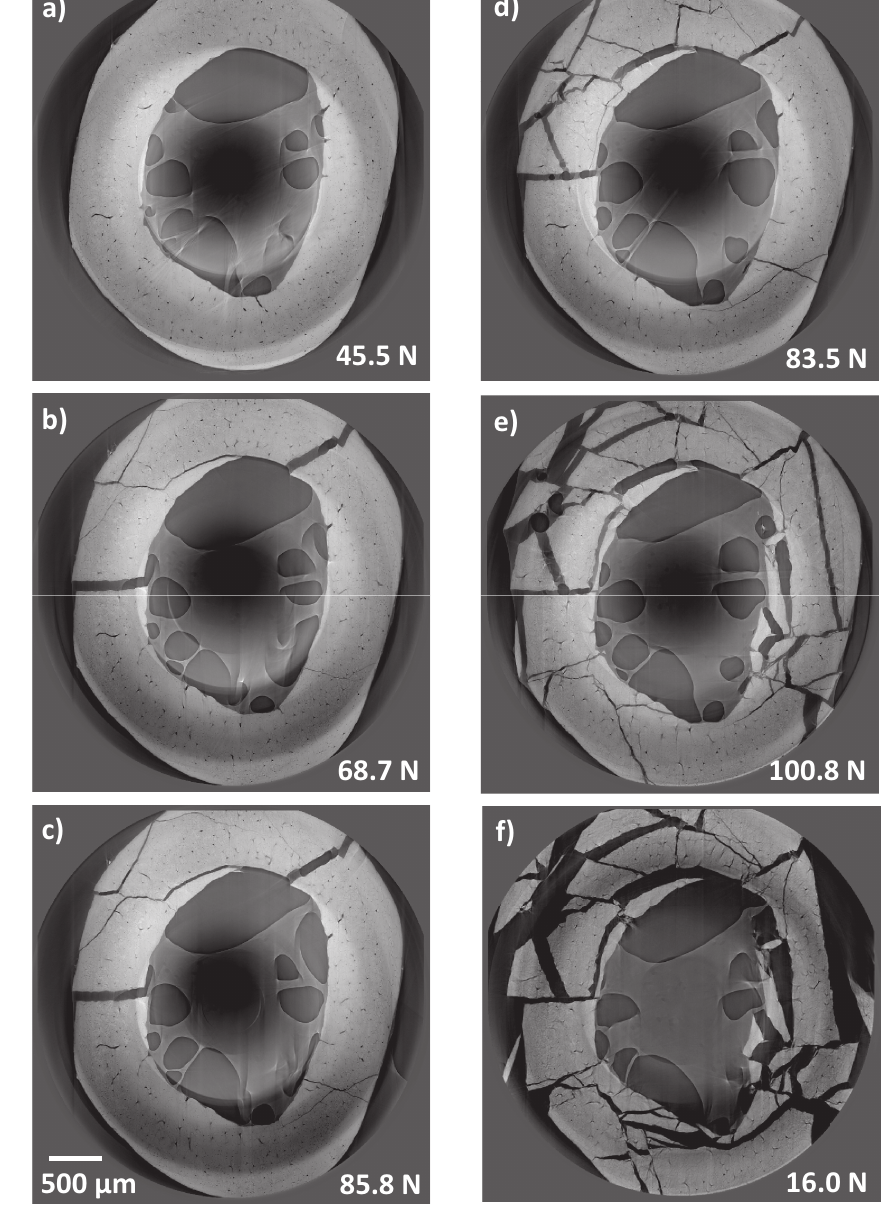
Figure 3. Cross-sectional tomographic slices (axial) of a force series showing a bioregenerated rat bone sample acquired with the TomoPress: (nominal) force values given for each image were measured via the force sensor in the head of “axis I”. Crack propagation through the fresh sample is excellently visible (strong cupping artifacts in the centre of the image are present due to imperfect flat field